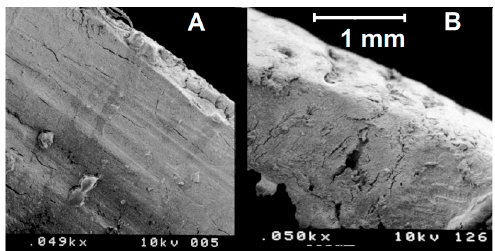
Figure 4. These SEM micrograph magnifications compare cortical bone preparations: ( a ) Performed with the drill; ( b ) performed with the ultrasonic technique. Compared with group A, the cortical bone of group B showed more opened vascular canals and an evident significant reduction of damage.